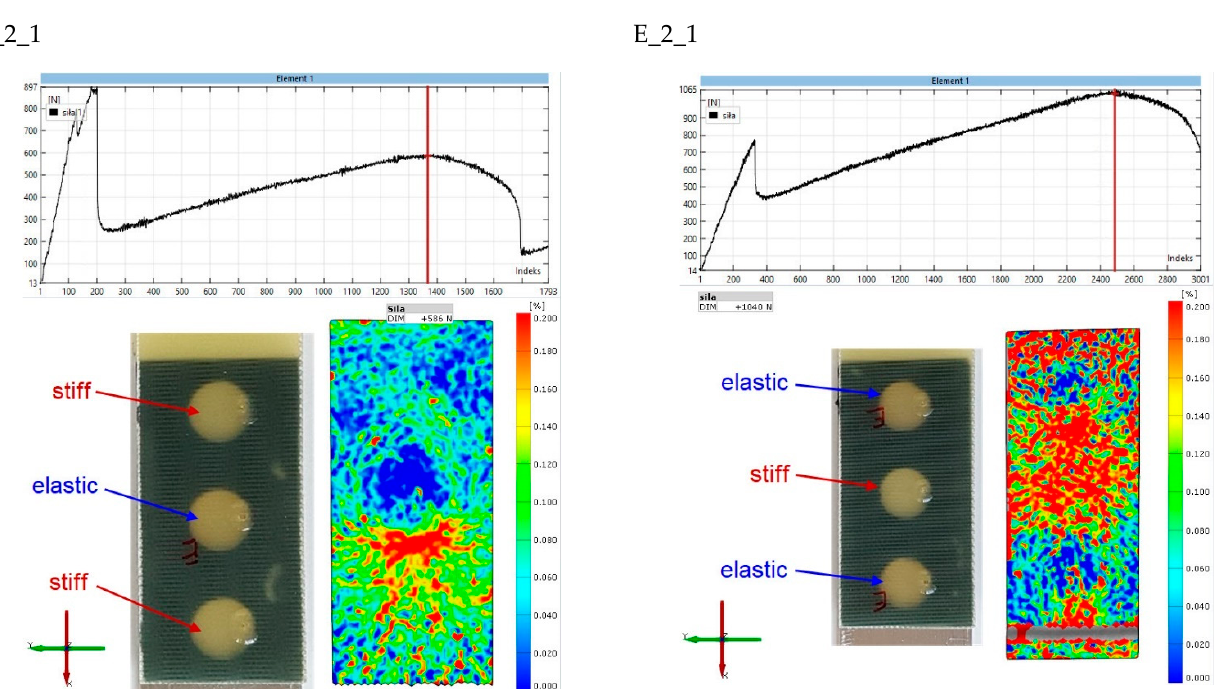
Figure 18. Comparison of principal strain maps for “S” and “E” batch 2 specimens for maximum force in the second stage of operation.